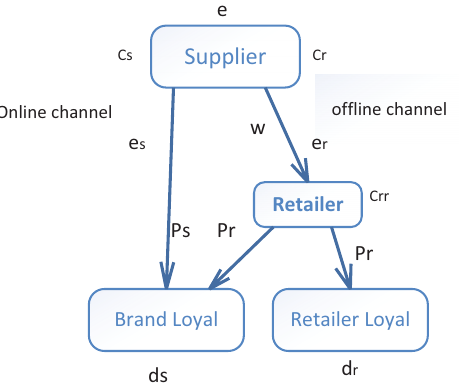
Figure 1. The two-echelon supply chain with online and offline selling